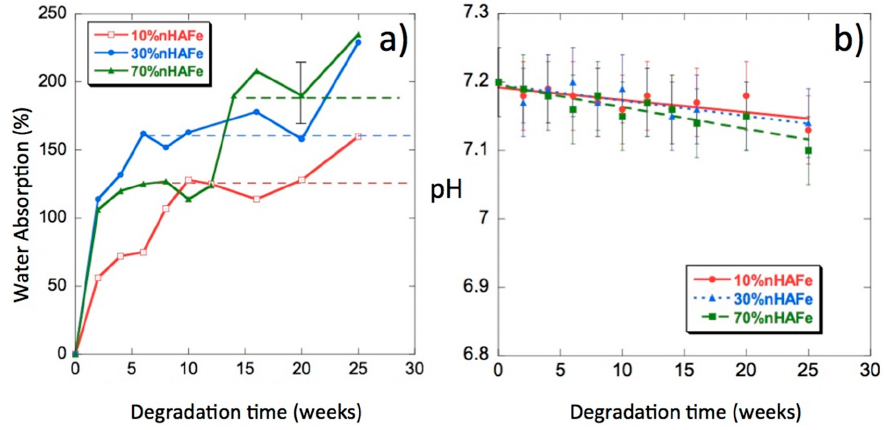
Figure 6. ( a ) Water absorption by PLLA/FeHA scaffolds vs. degradation time; ( b ) pH of the phosphate-buffered saline (PBS) solution vs. degradation time.